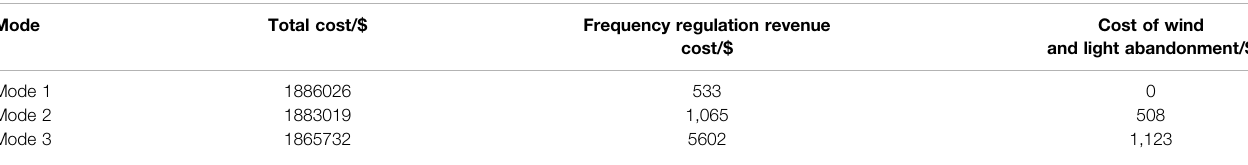
TABLE 2 | The cost comparison in three